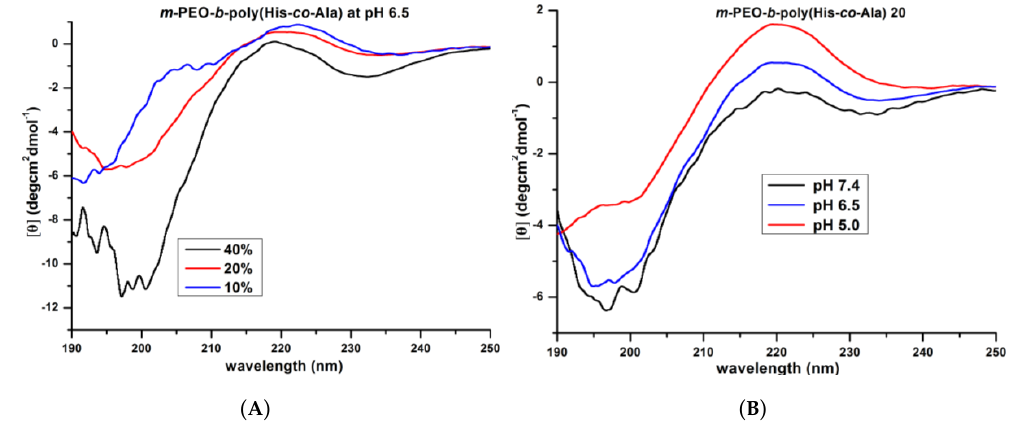
Figure 7. ( A ) CD of m- PEO- b -poly(His- co -Ala) with different Ala to His molar ratios at pH 6.5; ( B ) CD of m- PEO- b -poly(His- co -Ala) with 20% molar ratio of Ala residue to His residue as a function of pH.